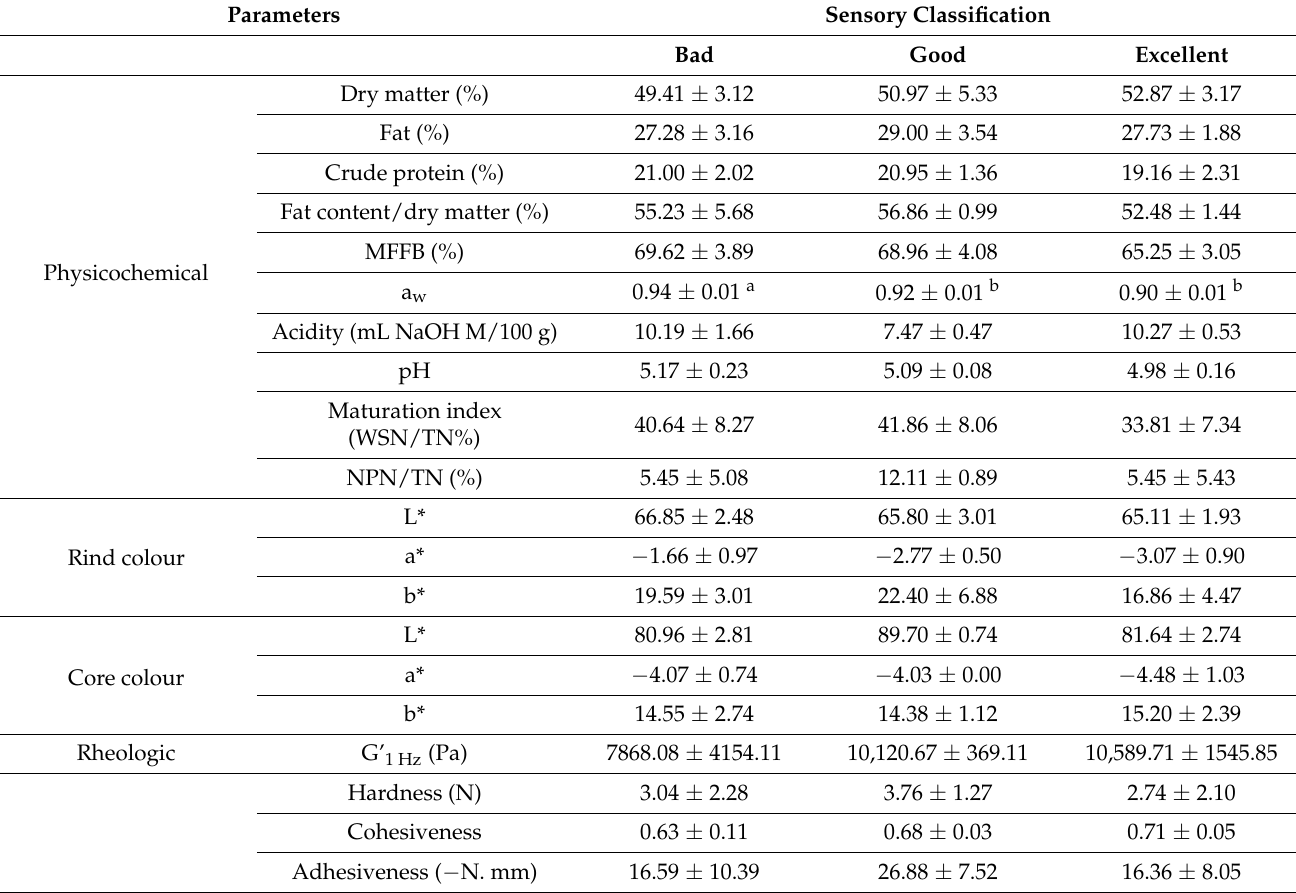
Table 3. Physicochemical and rheological parameters of cheeses grouped by sensory analysis.